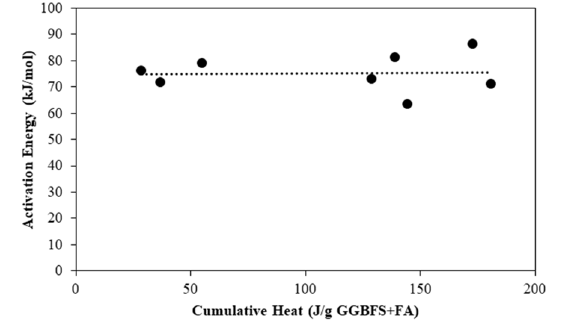
Figure 4. Evolution of the instanteneous apparent activation